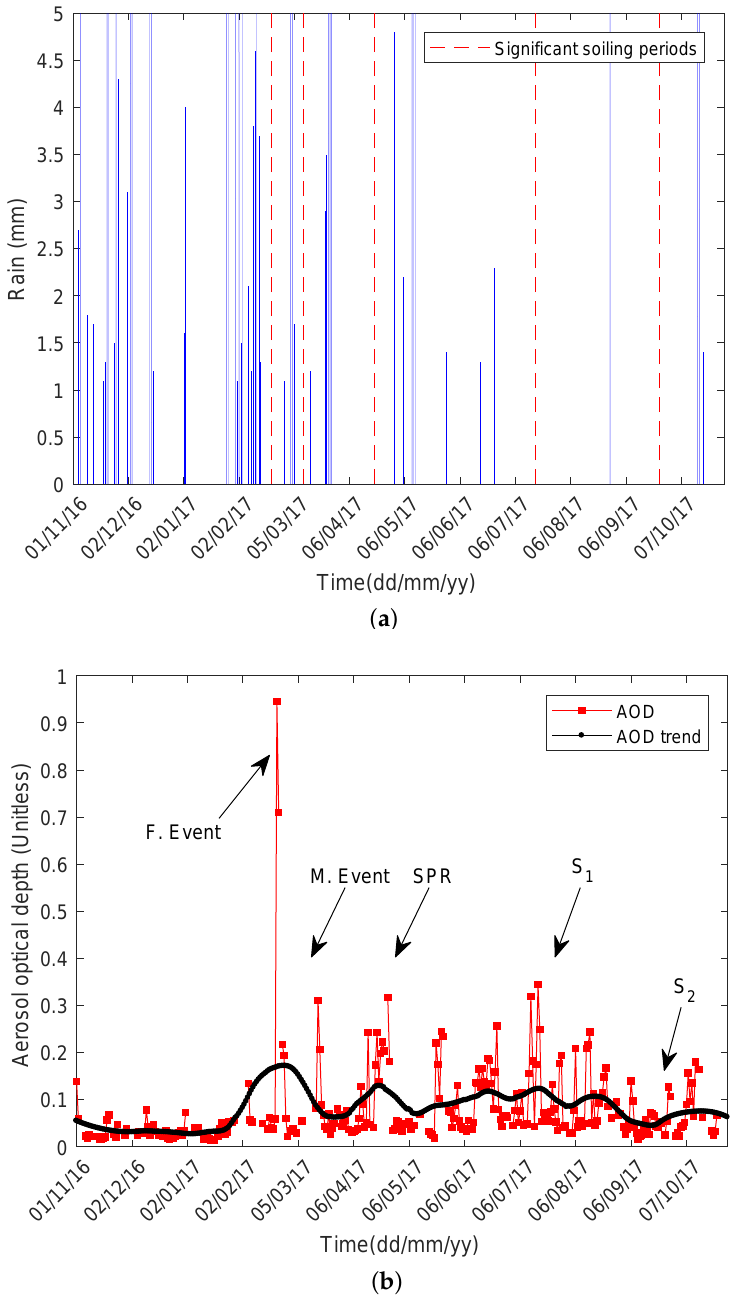
Figure 4. Environmental measurements: ( a ) rain; ( b ) aerosol optical